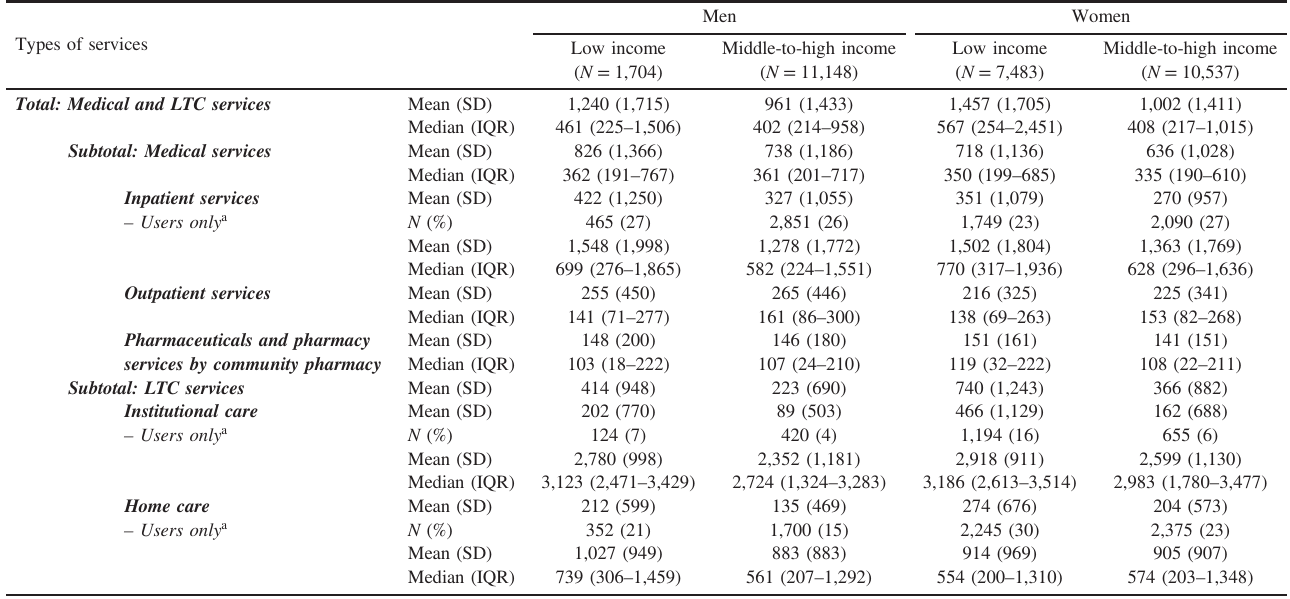
Table 4. Annual medical and long-term care expenditures (in JPY 1,000) by gender and household income category Types of services